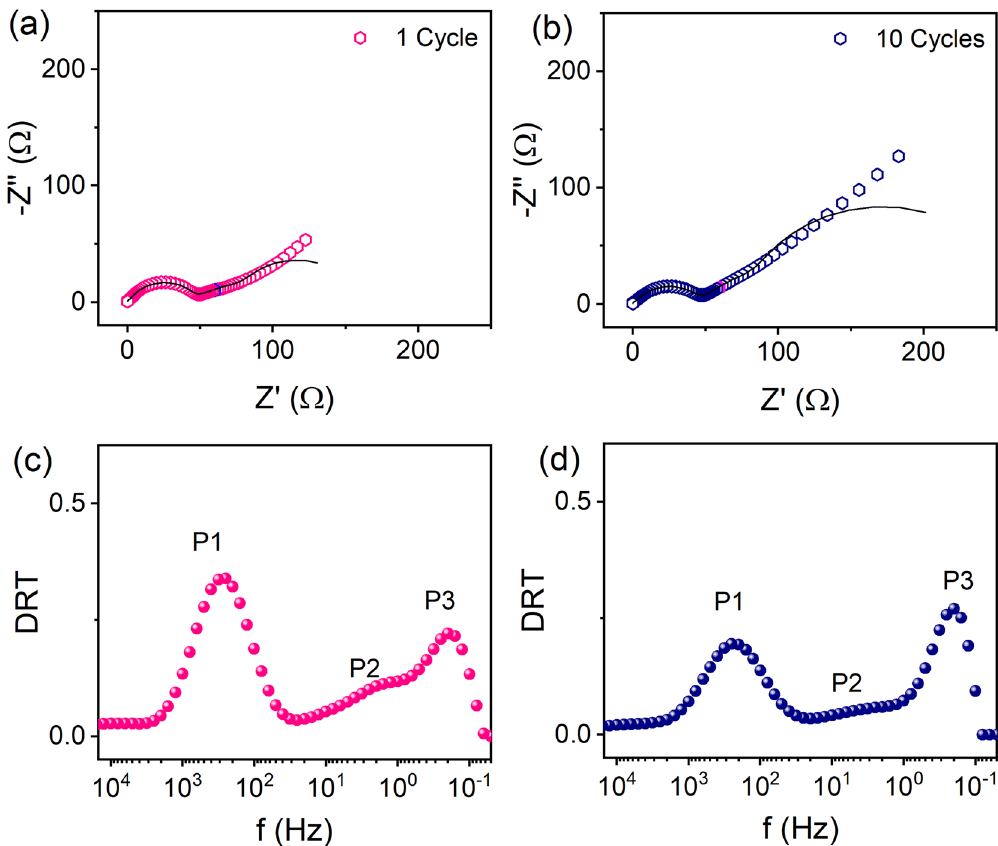
Figure 4. Nyquist plots of impedances from LIBs after ( a ) 1 cycle and ( b ) 10 cycles of charge/discharging and corresponding DRTs are shown in ( c,d ) respectively. The solid lines in ( a,b ) and ( b ) are the fit using the code. The solid symbol at 1 Hz is also marked in both ( a,b ).